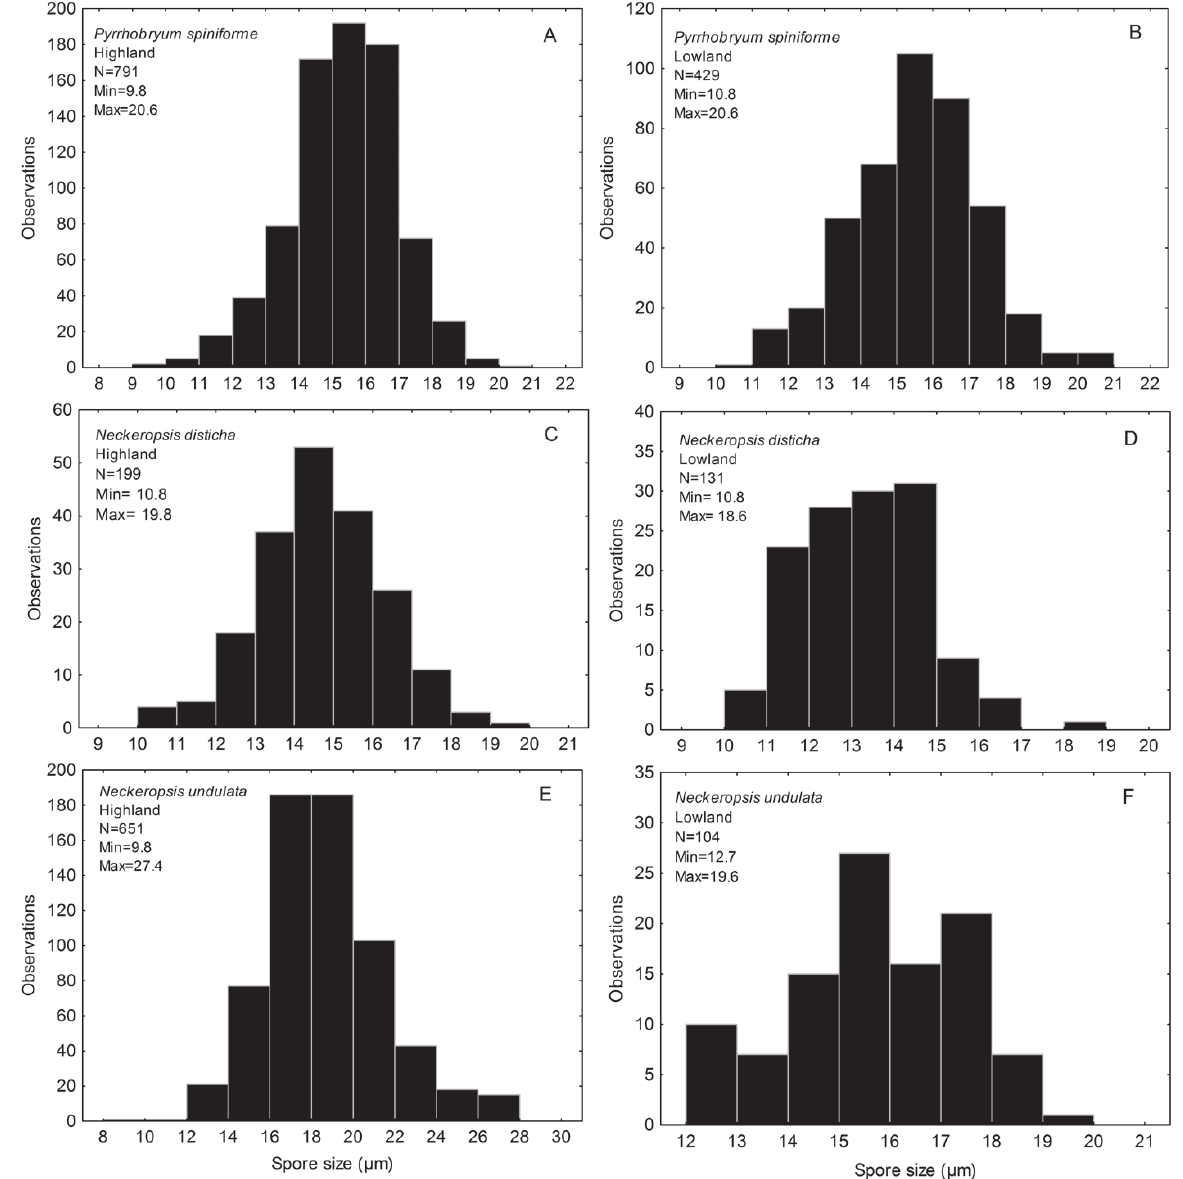
Figure 1 - A-F . Frequency histograms, minimum and maximum values of spore size in the tropical mosses Pyrrhobryum spiniforme , Neckeropsis undulata and N. disticha in Brazilian Atlantic forest sites. A-B . Pyrrhobryum spiniforme , C-D . Neckeropsis disticha , and E-F. Neckeropsis undulata , in highland and lowland areas,